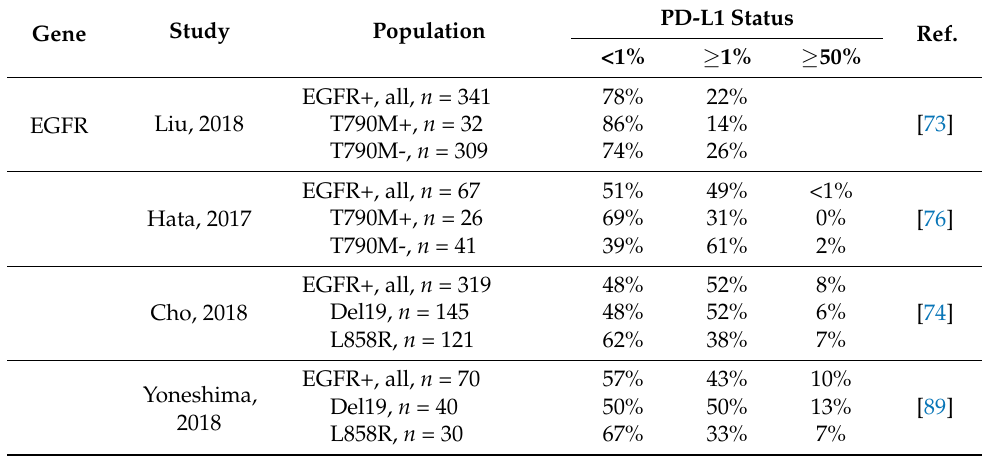
Table 3. PD-L1 expression in NSCLC with actionable oncogenic driver